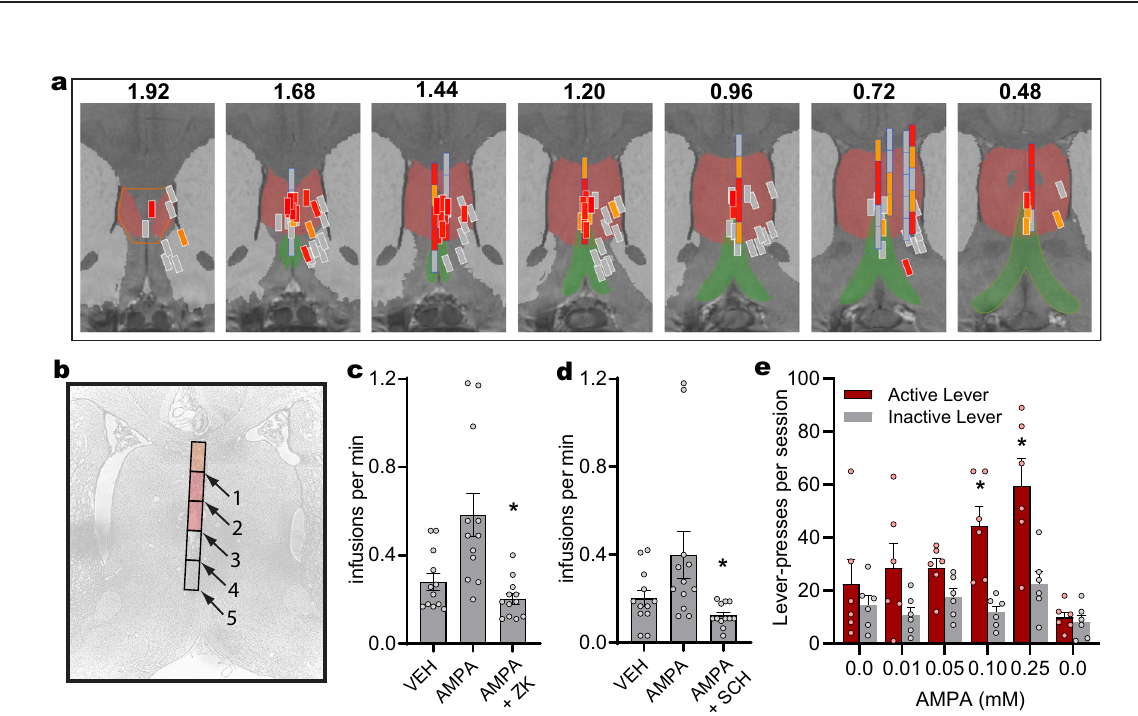
Fig. 2 SuM GLU neurons projecting to the septum and to the paraventricular thalamic nucleus mediate positive and negative reinforcements, respectively. a Schematics showing Cre-speci fi c virus injections into SuM and optogenetic stimulation sites in Sept ( n = 23 mice) vs vSub ( n = 7 mice) or Sept vs PVT ( n = 12 mice). Data are mean lever presses with SEM for each group. Gray, orange, and purple circles indicate data with septal, vSub, and PVT stimulation, respectively. b Summary of active lever-presses (mean − SEM) per session. See ( a ) for procedure and n ’ s. In addition, AAV was injected into VTA with fi ber placed in septum ( n = 6 mice). ** p ’ s < 0.005, SuM:Sept vGlut2 responding more than any other groups over sessions 3 – 7, Tukey HSD post hoc test. c c-Fos expression after stimulation at respective sites. Arrows indicate the tips of optic fi ber; green labels indicate vGlut2 neurons expressing ChR2 (scale bar = 200 µ m); and c-Fos-ir is shown in red (scale bar = 100 µ m). d c-Fos counts (mean + SEM). c-Fos counts in septum (stimulation, n = 8 mice; non-stimulation, n = 9 mice) and PVT (stimulation, n = 6; non-stimulation, n = 5) were signi fi cantly greater when stimulated than when not (unpaired t -test, *** p ’ s < 0.001). In the vSub, c-Fos counts were signi fi cantly greater in the hemisphere ipsilateral to stimulation than contralateral to stimulation ( n = 8 mice) or when not stimulated ( n = 7 mice). * p < 0.001, Bonferroni test. e Schematic of optogenetic preparation of within-subject comparison of SuM:Sept vGlut2 vs SuM:PVT vGlut2 pathways in real-time place preference. f Schematic of real-time place preference chamber. The stimulation compartment (STM) is shown with a dotted line. g Time spent in stimulation side ( n = 8 mice; mean + SEM) of the real-time place preference/ aversion chamber during baseline (no stimulation) session and stimulation session with septal or PVT stimulation. ** p < 0.001, * p < 0.01, Bonferroni test. h Example heatmaps of mouse position showing time spent in each compartment. Warmer colors indicate more time spent in that area. Source data are provided as a Source Data fi le.